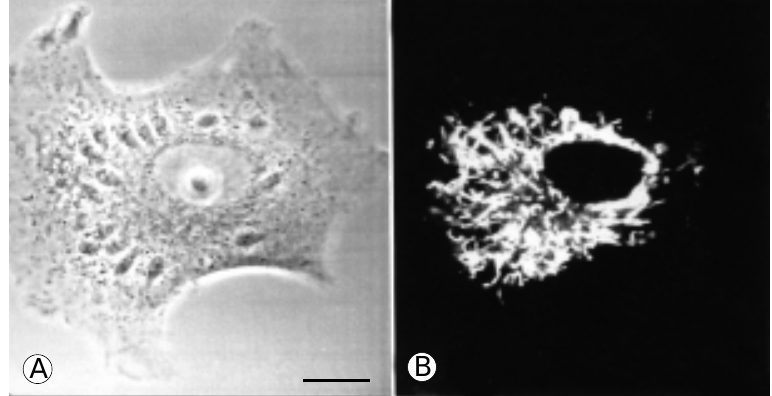
Figure 10 - Localization of the endoplasmic reticulum, using anti-calreticulin antibodies, in cells infected with Toxoplasma gondii . A , Interference micros- copy; B , CLSM. Labeling of the perivacuolar region and of the intravacuolar tachyzoites is ob- served. Bar = 2.2 µm.